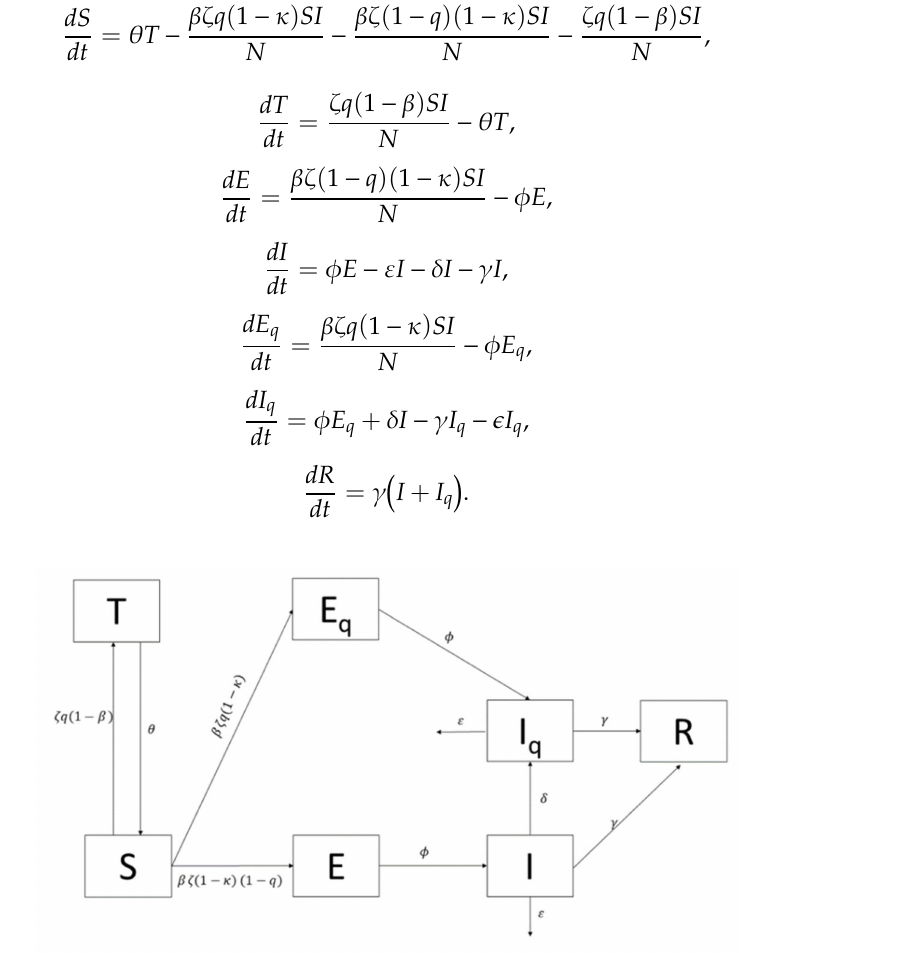
Figure 1. The extended susceptible, exposed, infectious, recovered model depicting the control measures taken in Malaysia. The additional compartments are the traced close-contact and a negative test result population ( T ), the traced exposed close-contact and positive test result population ( E q ) undergoing quarantine, and the infected isolated ( I q